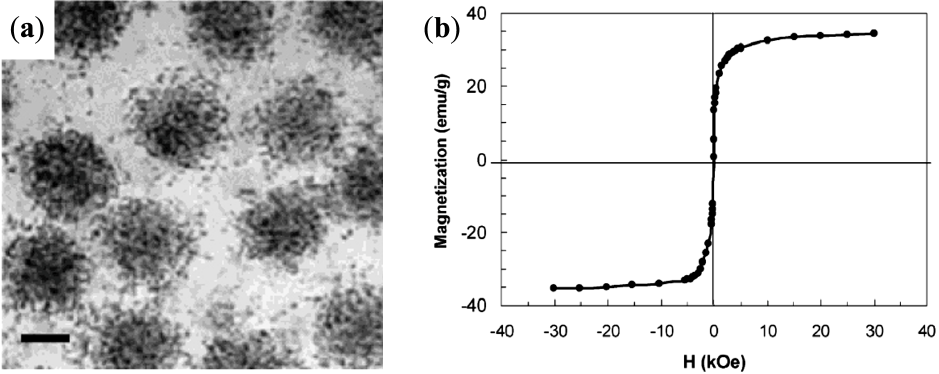
Figure 33. ( a ) TEM image for hybrid poly( N -isopropyl acrylamide- co -acrylic acid- co -2-hydroxyethyl acrylate) (poly(NIPAM- co -AA- co -HEA)) microgels loaded with O /g polymer; the scale bar is 150 nm; and ( b ) magnetization curve at 300 K. 0.618 g Fe 3 4 Reprinted with permission from [60]. Copyright 2004 American Chemical